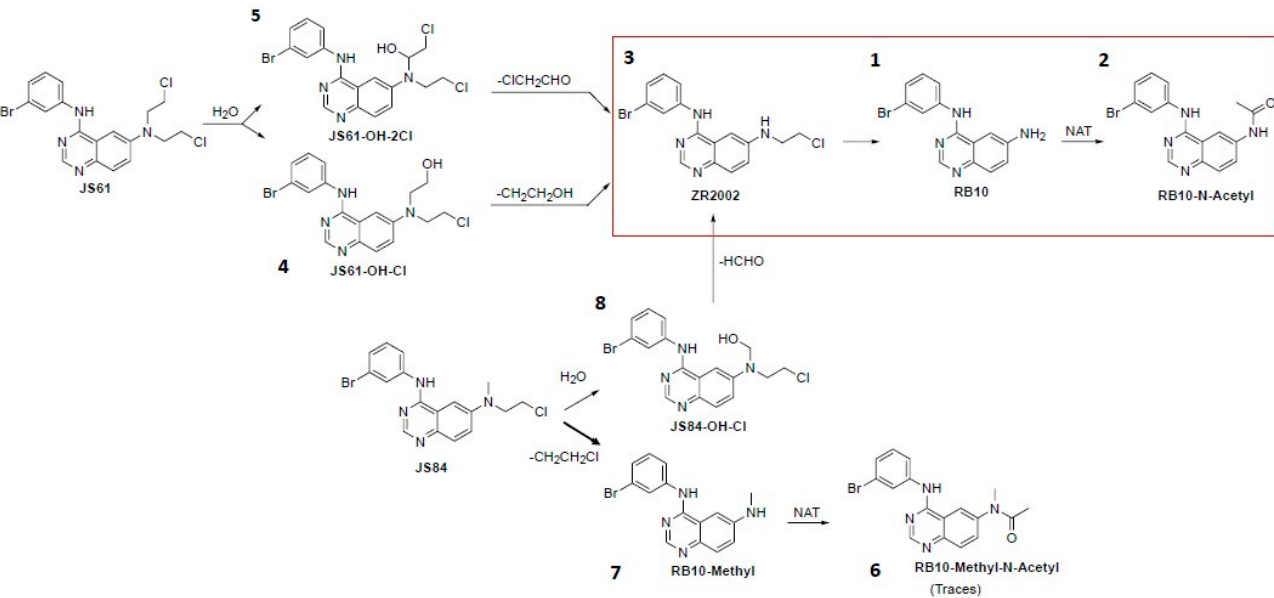
Figure 7. Scheme of combi-molecule metabolizations. All combi-molecules share the metabolic pathway of ZR2002, marked with the red rectangle. JS61 partially hydrolyzes, generating metabolites 4 and 5, of which concentrations are not sufficient to generate high concentrations of ZR2002 metabolite. JS84 generates high concentrations of RB10-Methyl and is not hydrolyzed enough in JS84-OH-Cl to generate high levels of ZR2002. Each metabolite has a name and number that refers to the chromatogram in Figure 6A.